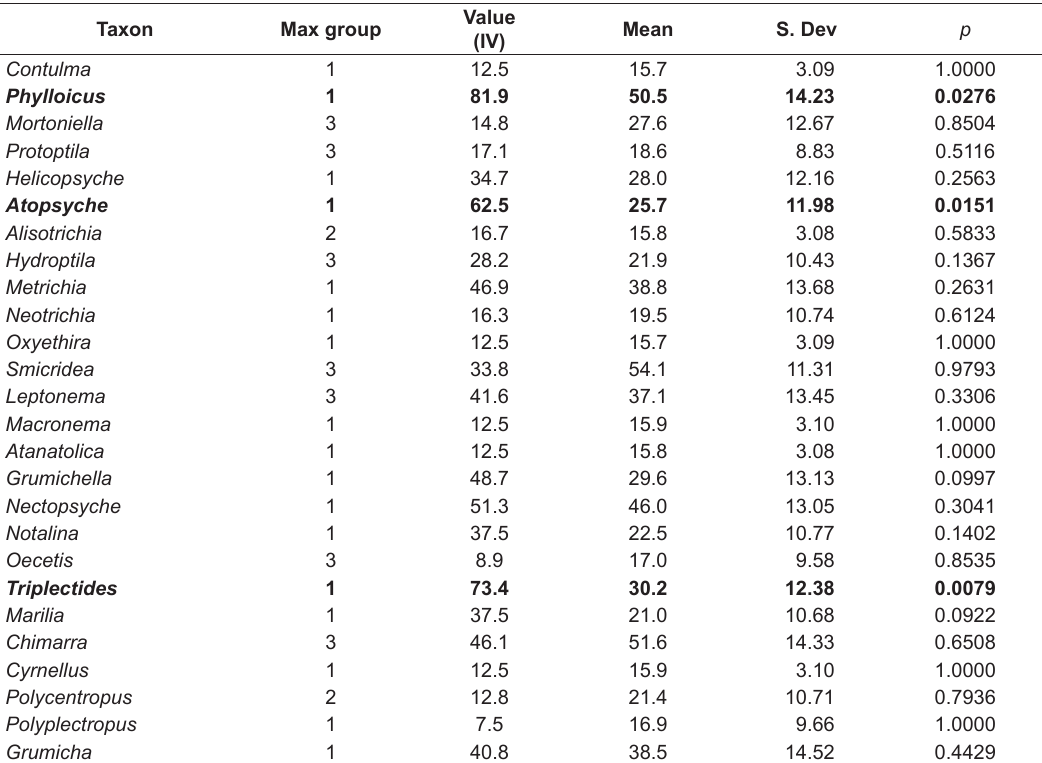
Table 4. Taxa with significant values of Indication ( p < 0.05, 1000 permutations) for each site group (reference, intermediate and poor streams) studied at Serra da Bocaina Mountain, Southeastern Brazil. Where Max Group 1: reference; max group 2 – intermediate and max group 3 –